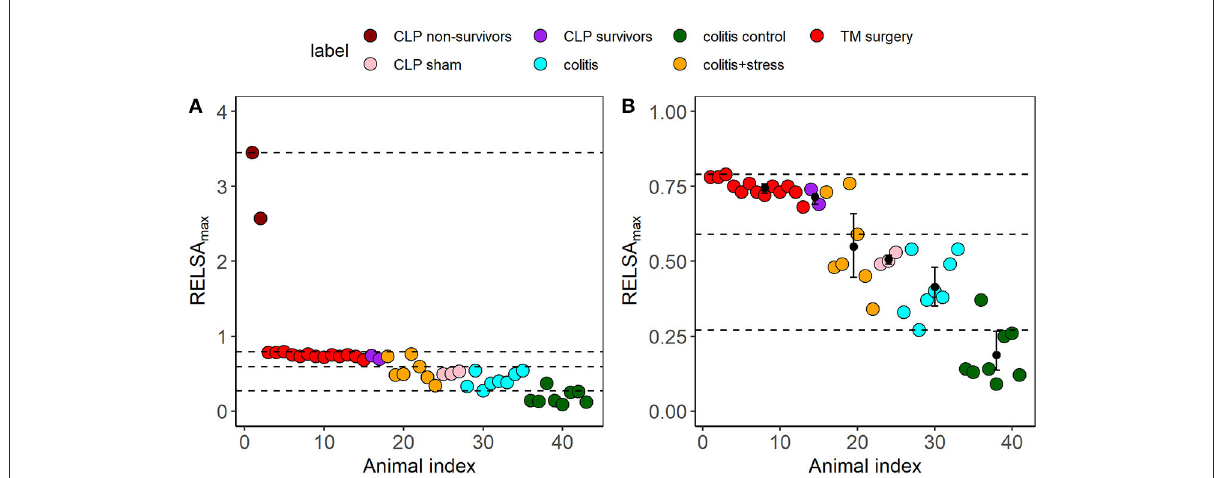
FIGURE6 (A) Cluster analysis and severity categorization of six distinct subgroups from the three independent animal studies cecal ligation puncture (CLP, sepsis), surgery (TM implantation), and colitis/restraint stress using the RELSA max as the maximum experienced severity information. Each dot represents an animal. In all subgroups, the outcome measures bwc, hr, hrv, temp, and act were used to calculate the RELSA max . The dashed lines represent the four severity thresholds from a k-means clustering (L1 < 0.27, L2 < 0.59, L3 < 0.79, and L4 < 3.45) to enable a comparative grading and categorization of the models and animals. The highest severity was reached by the two CLP non-survivors (RELSAmax > 2.5). (B) The bootstrapped cluster centers with 95% confidence intervals show that except for the colitis + stress model data, the 95% CIs remain within the identified cluster levels, indicating highly stable severity estimates. Individual animals in the colitis control group showed increased severity due to a drop in activity. Note that the RELSA scale focuses on the range RELSA[0;1]; therefore, the two CLP non-survivors are not visible.